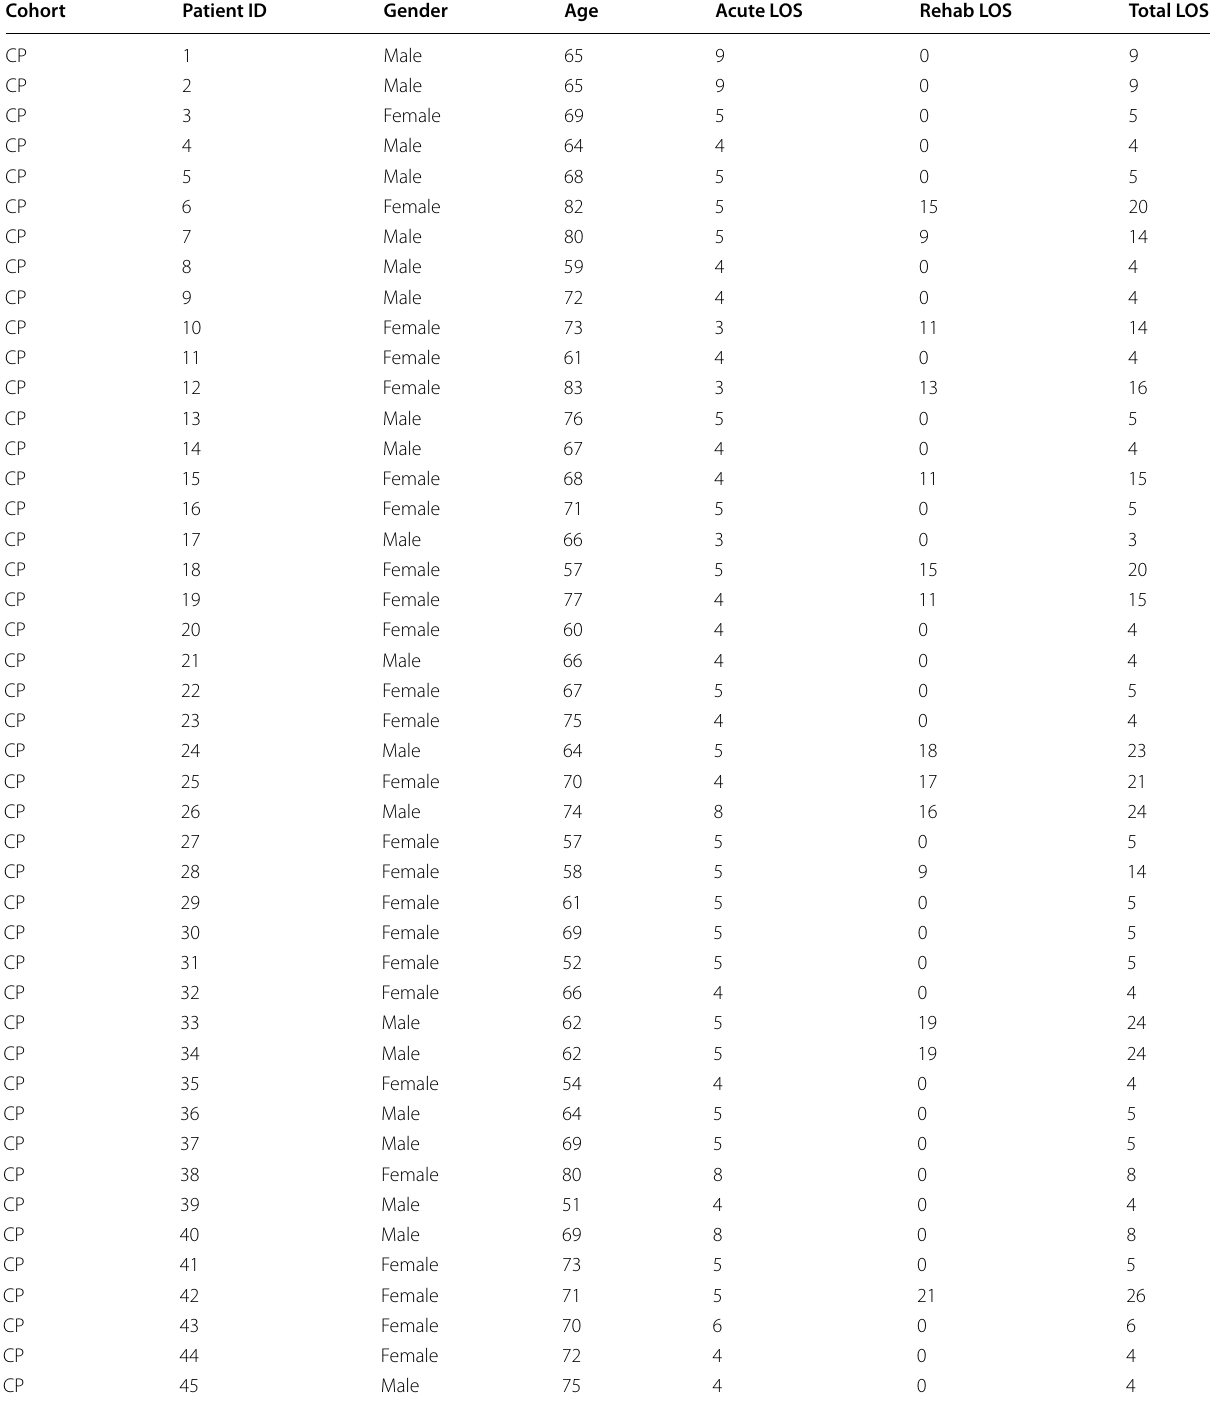
Table 3 Raw, de‑identified patient data of both cohorts after the application of propensity score matching (CP cohort, n cohort, n 124), including gender, age, and length of =